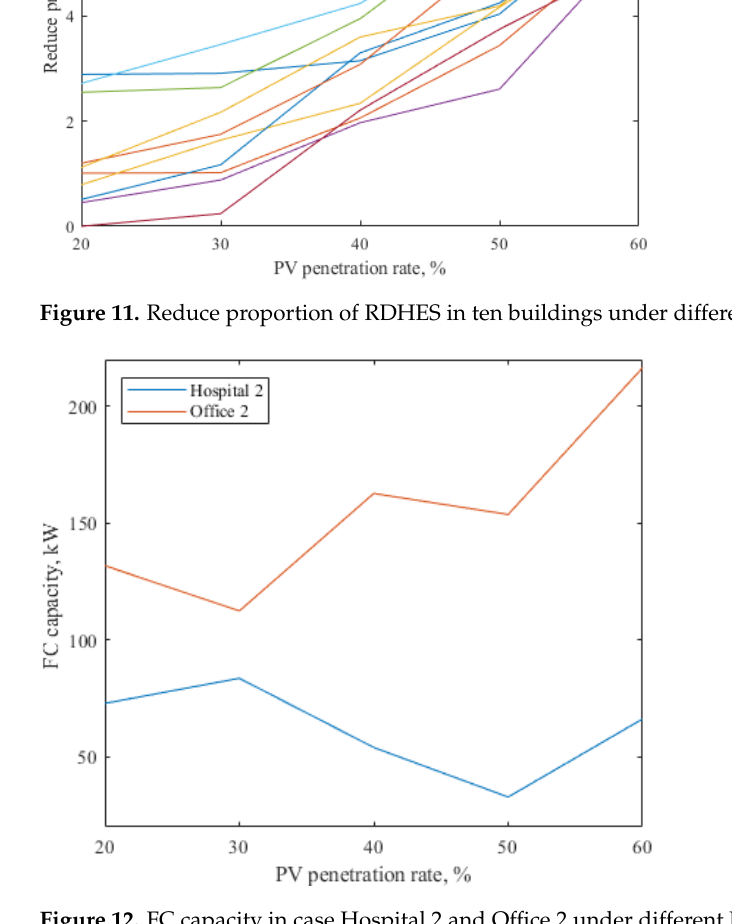
Figure 12. FC capacity in case Hospital 2 and Office 2 under different PV penetration.